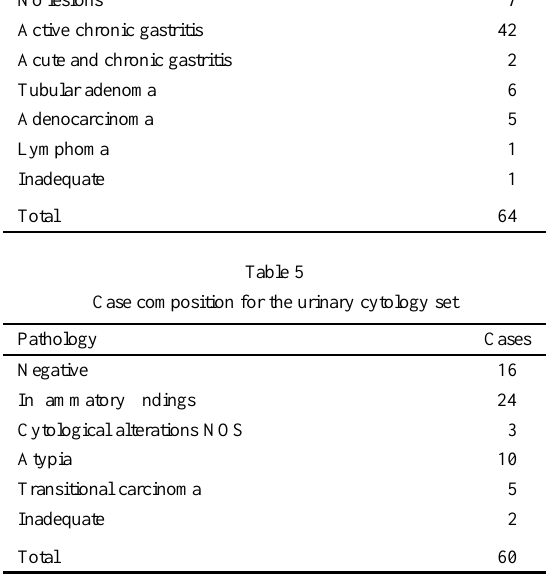
Case composition for the gastrointestinal pathology set Pathology